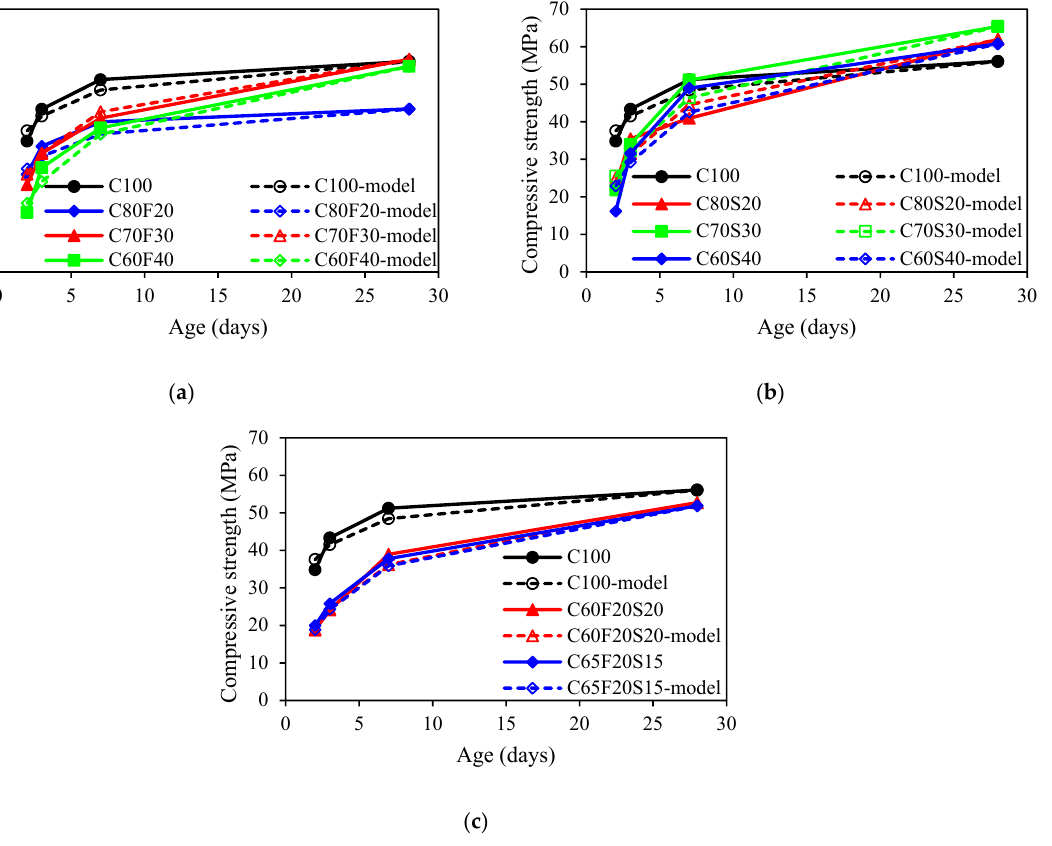
Figure 12. Comparison between experimental data and predicted compressive strength using pro- posed models for s 1 : ( a ) fly ash group; ( b ) GGBFS group; ( c ) ternary binder